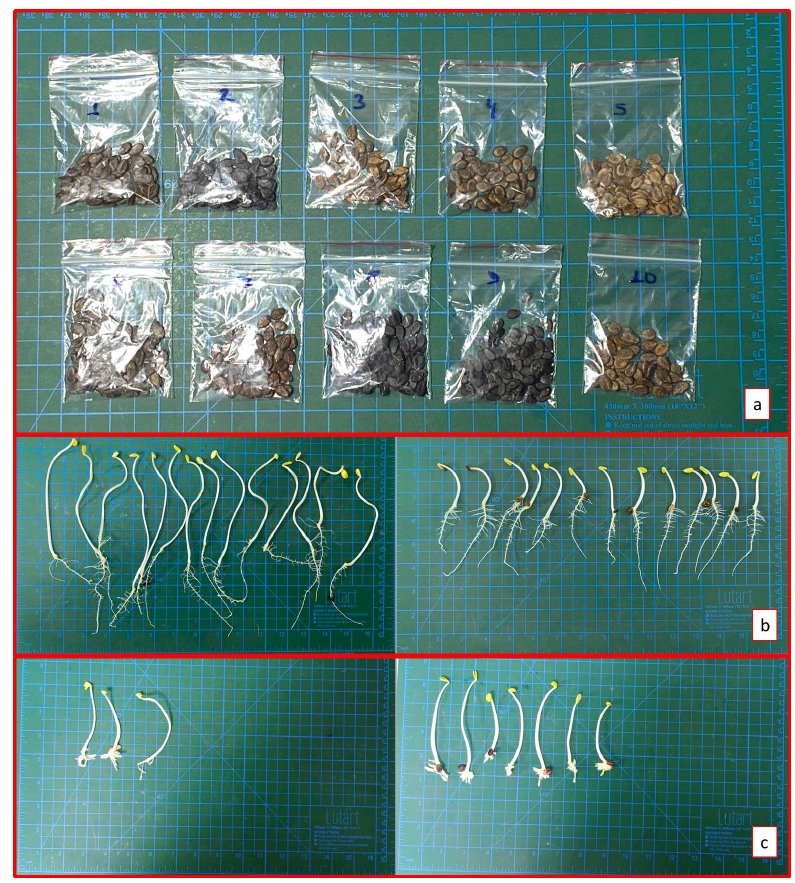
Figure 1. Watermelon seed moisture equilibration among the seeds within the bag 17 ± 0.3% of moisture content ( a ), germination tests at 25 °C for fourteen days in the dark ( b ), and normal and abnormal seedling ( c ).